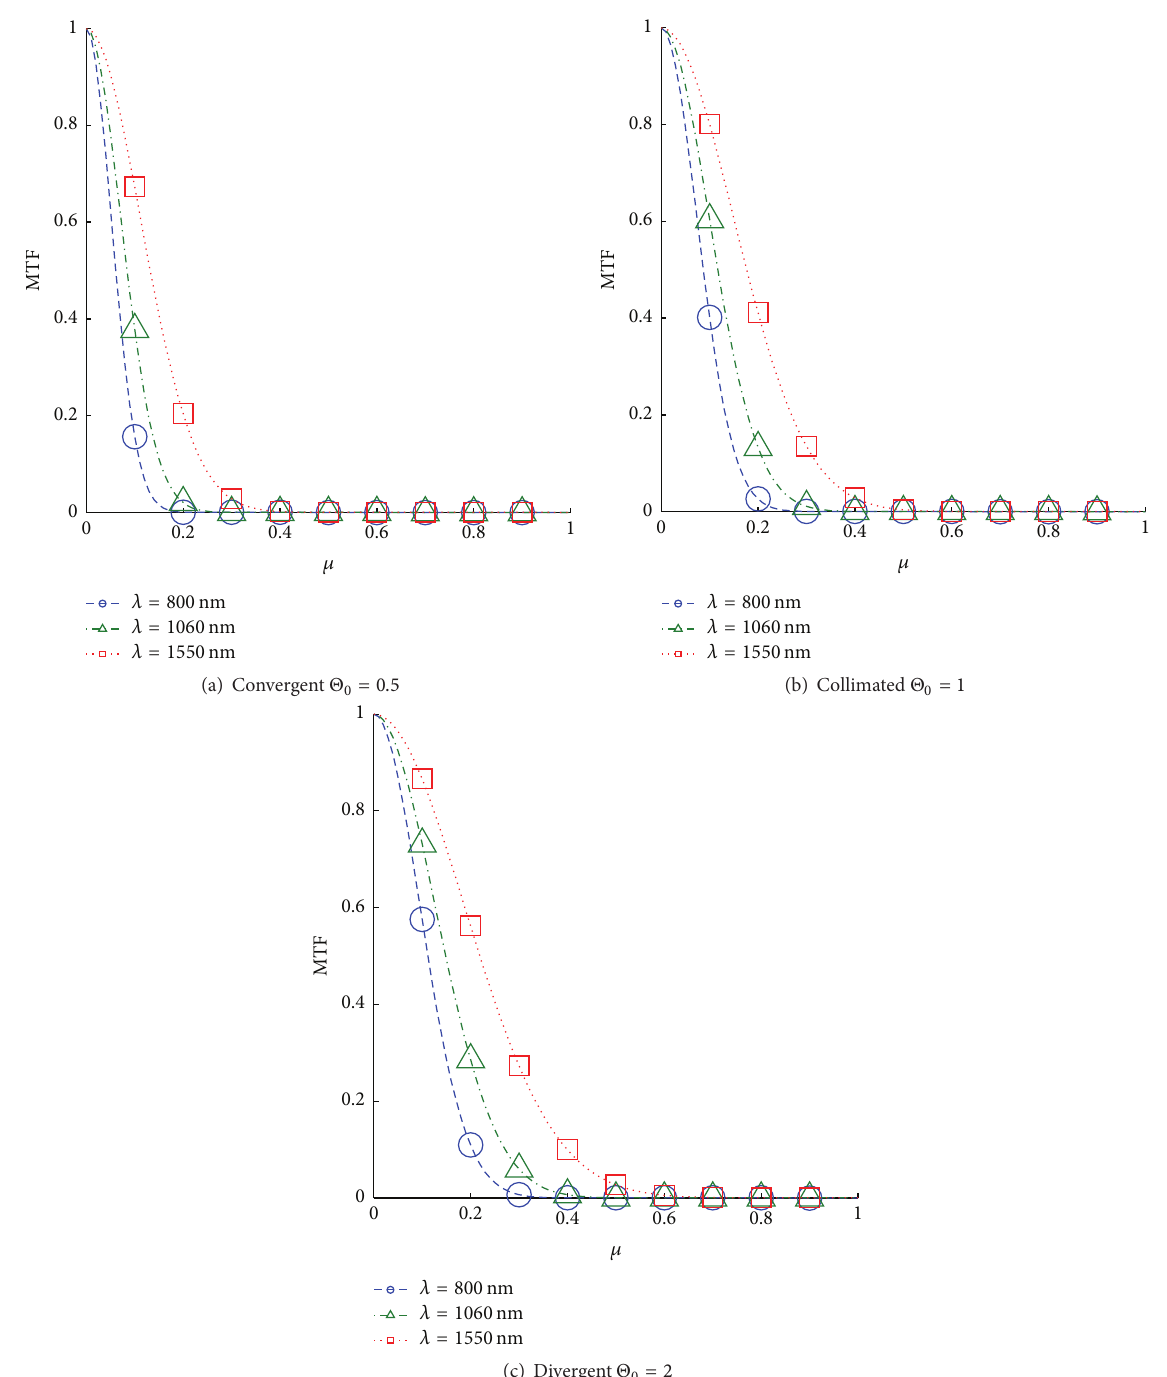
Figure 4: Effects of wavelength on MTF for different types of Gaussian